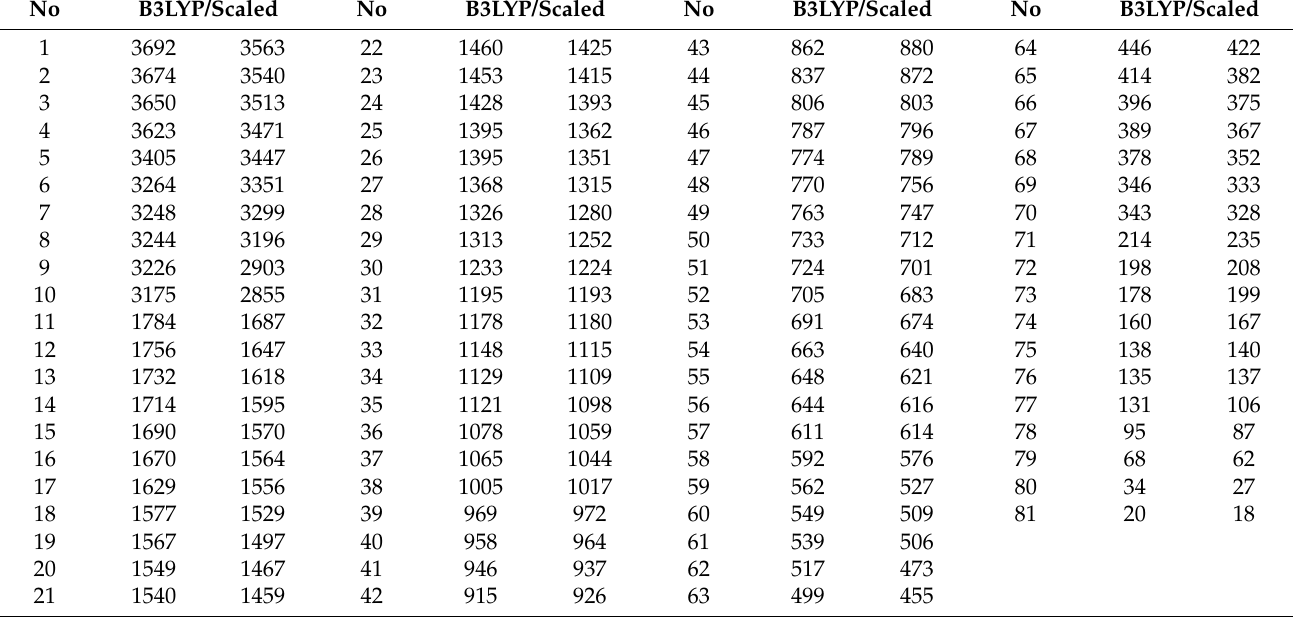
Table 5. Guanine–cytosine pair: B3LYP/6-31G* frequencies and frequencies for the scaled force matrix (cm − 1